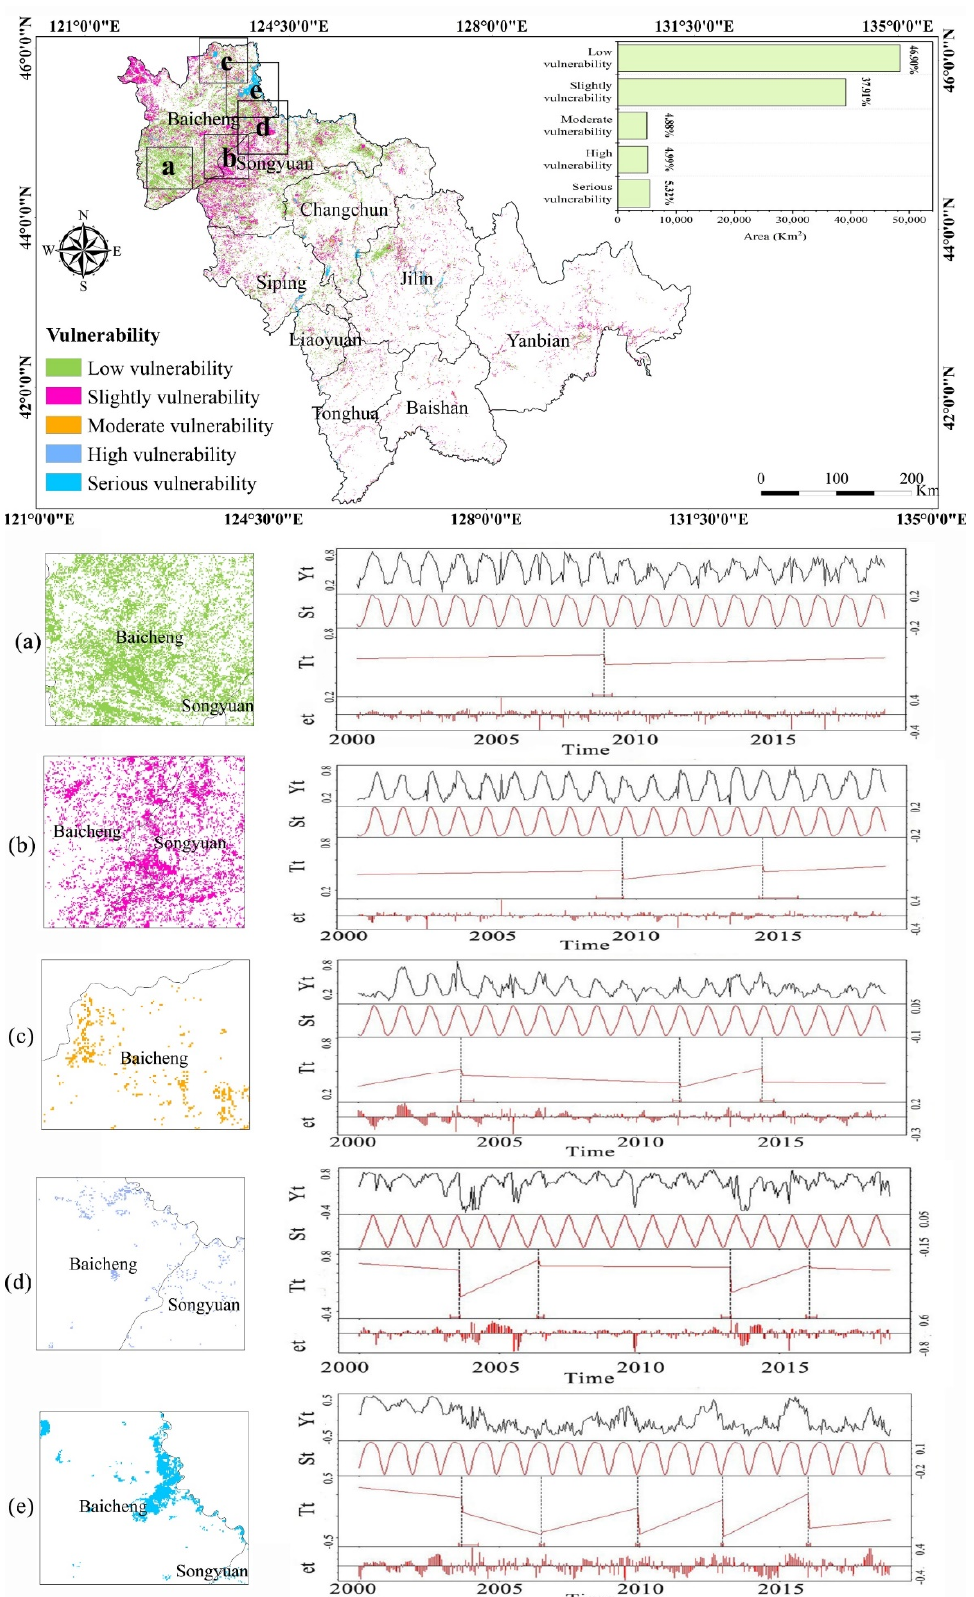
Figure 6. Spatial distribution of the ecologically vulnerable area and the BFAST results for different levels of vulnerability: ( a – e ) Spatial distribution and temporal changes of low vulnerability, slight vulnerability, moderate vulnerability, high vulnerability, and serious vulnerability, respectively.